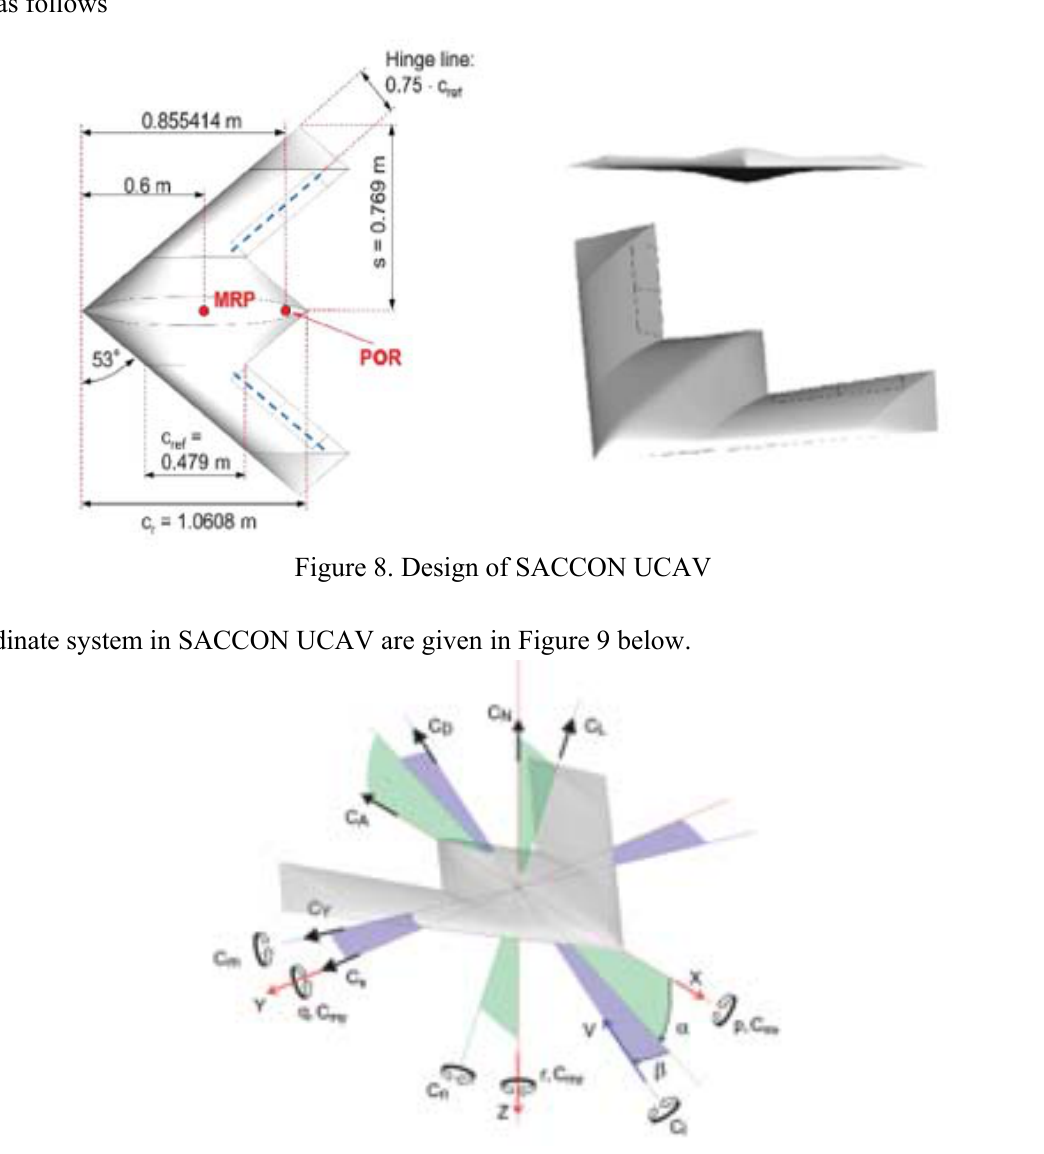
Figure 9. Coordinate System of SACCON